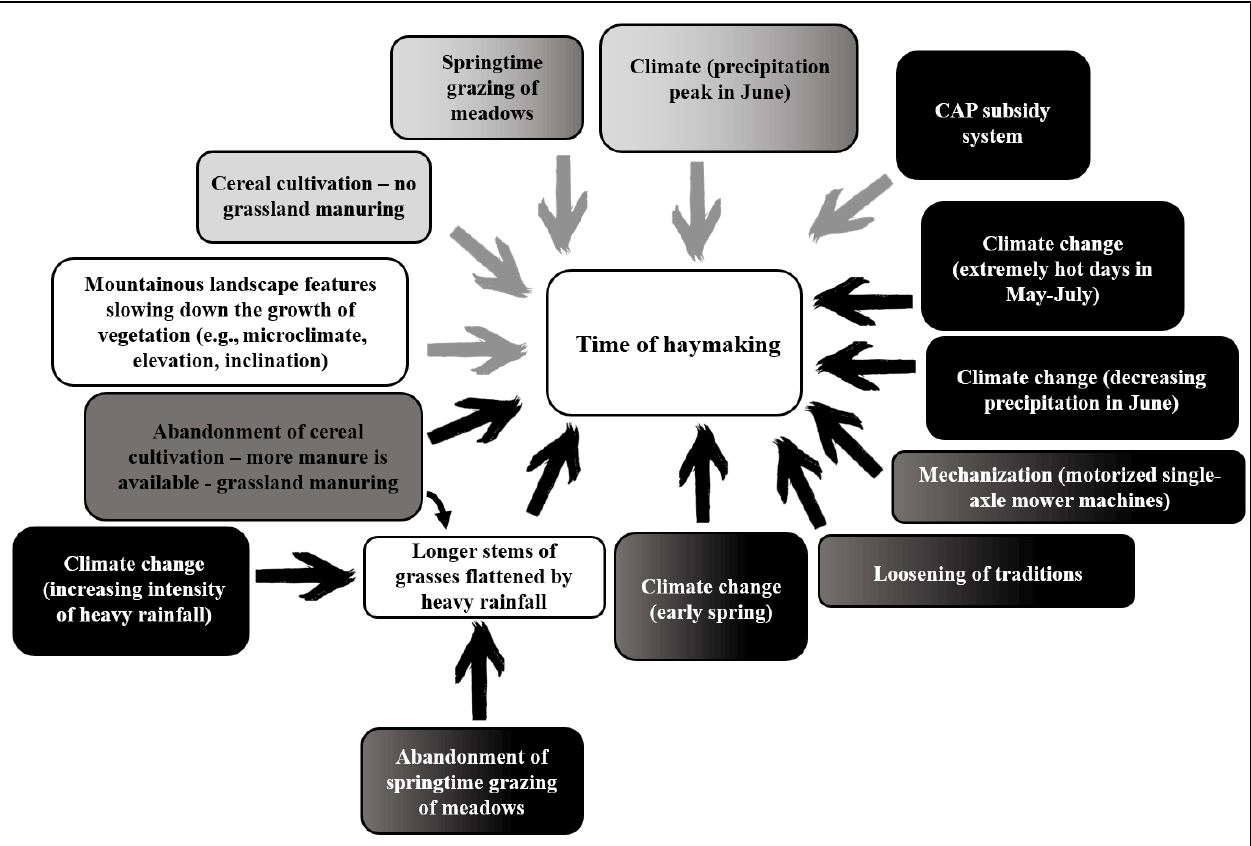
Fig. 6 . The direct and indirect drivers influencing the time of mowing. The colors of the arrows: grey arrows indicate delays to the time of mowing, whereas black arrows indicate advances to the time of mowing. The colors of the “driver boxes” show the periods examined: light grey means P1, dark grey means P2, black means P3, while boxes shaded in transitions of two colors refer to drivers found in two periods. The white boxes refer to drivers found in all three of the periods